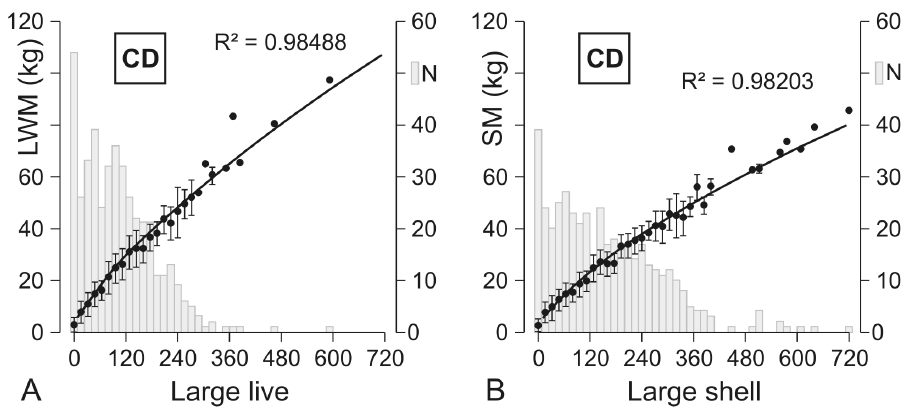
Figure 14. CD-density scaling of large oysters. A Plotted is LWM (kg) ± SD against large live oysters per abundance class. B Plotted is SM (kg) ± SD against large oyster shell per abundance class. Abundance class- es derived from pooling 432 stations to intervals of 16 large oyster CD, respectively. N = Number of stations per abundance class (bars). Powered relationship indicated and coefficient of determination (R²) given. Scaling parameters listed in Table 2 (7, 8). Density metrics and density attributes according to Figure